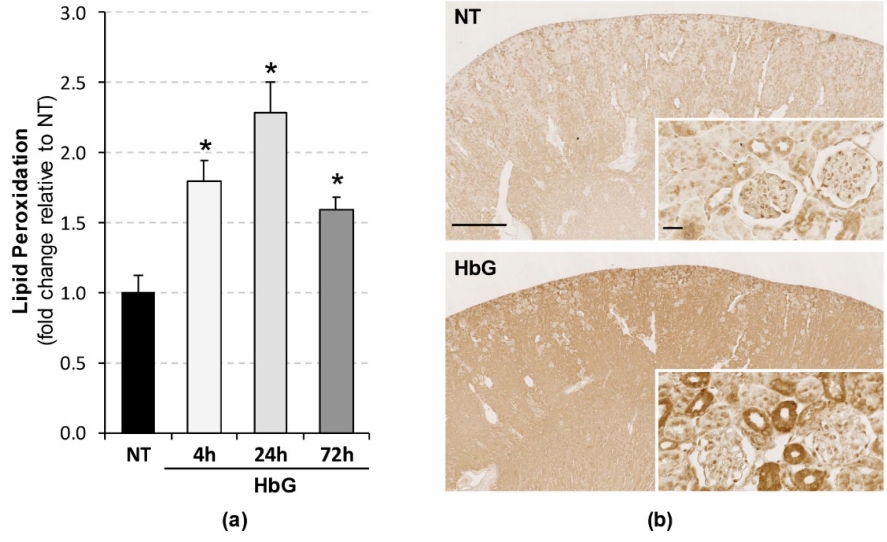
Figure 5. Renal lipid peroxidation following HbG infusion. ( a ) MDA+HAE levels were analyzed in renal tissue homogenates as described in the Materials and Methods. Results were calculated as pmol/mg protein and presented as the fold change relative to sham controls. Data are shown as the means ˘ SE for at least four animals per time interval. * p < 0.05 versus NT; ( b ) 4-HNE immunohistochemistry showing enhanced immunoreactivity (brown signal) in HbG group (4 h post-ET) compared to NT. Scale bars: 1 mm (main panels) or 25 µ m